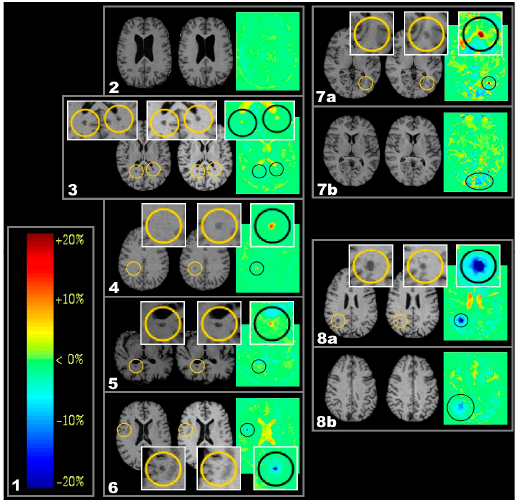
Figure 1. One year follow-up T1-weighted (T1w)) magnetic resonance images (MRI) and respective colour coded voxel-guided morphometry (VGM) maps demonstrating different types of volume change. Important detail is highlighted in circles. ( 1 ) Colour scale encoding of VGM data. On the right, the volume alteration is given in ten-percent-intervals; on the left, the according colours as depicted in VGM images are given. Stability of brain volume (equivalent to a volume change of 0%) is represented by a light green colour; volume reductions (volume change < 0%) are represented by cold colours, and volume expansions (volume change > 0%) by warm colours; ( 2 – 6 ) From left to right: MRI-1), MRI-2), and VGM; ( 2 ) Exemplary case demonstrating lack of volume change; ( 3 ) Exemplary case demonstrating two inactive lesions, each located close to the posterior horn of the lateral ventricle. They show low volume increase below the cut-off point (light yellow in VGM); ( 4 ) Exemplary new lesions (NL) (red in VGM and new in MRI-2) located in the right centrum semiovale; ( 5 ) Exemplary chronic enlarging lesions (CEL) (red in VGM and enlarged in MRI-2) dorsal to posterior horn of the right lateral ventricle; ( 6 ) Exemplary chronic shrinking lesions (CSL) (blue in VGM and shrunken in MRI-2); ( 7a – 7b ) Exemplary NL that involving fibers of the optic radiation ( 7a ). The dependent occipital area shows signals of volume decrease ( 7b ); ( 8a – 8b ) Exemplary CSL with light blue halo indicating shrinkage effects along beyond the originally visible lesion ( 8a ); this is even visible in a neighbouring slice that did not contain the original lesion ( 8b ).